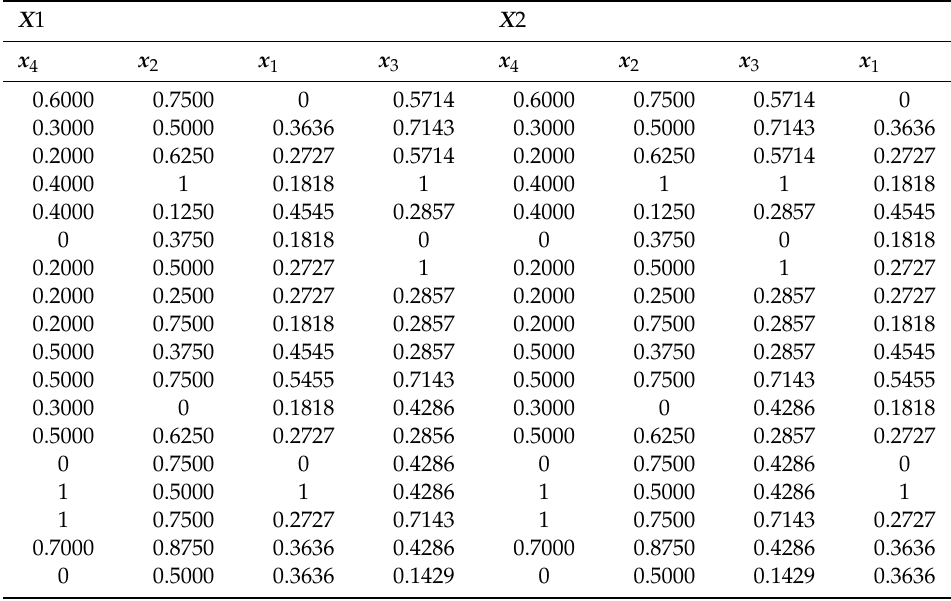
Table 3. Normalized values of matrices X 1, X 2, Normalization Method 1, α = 1.